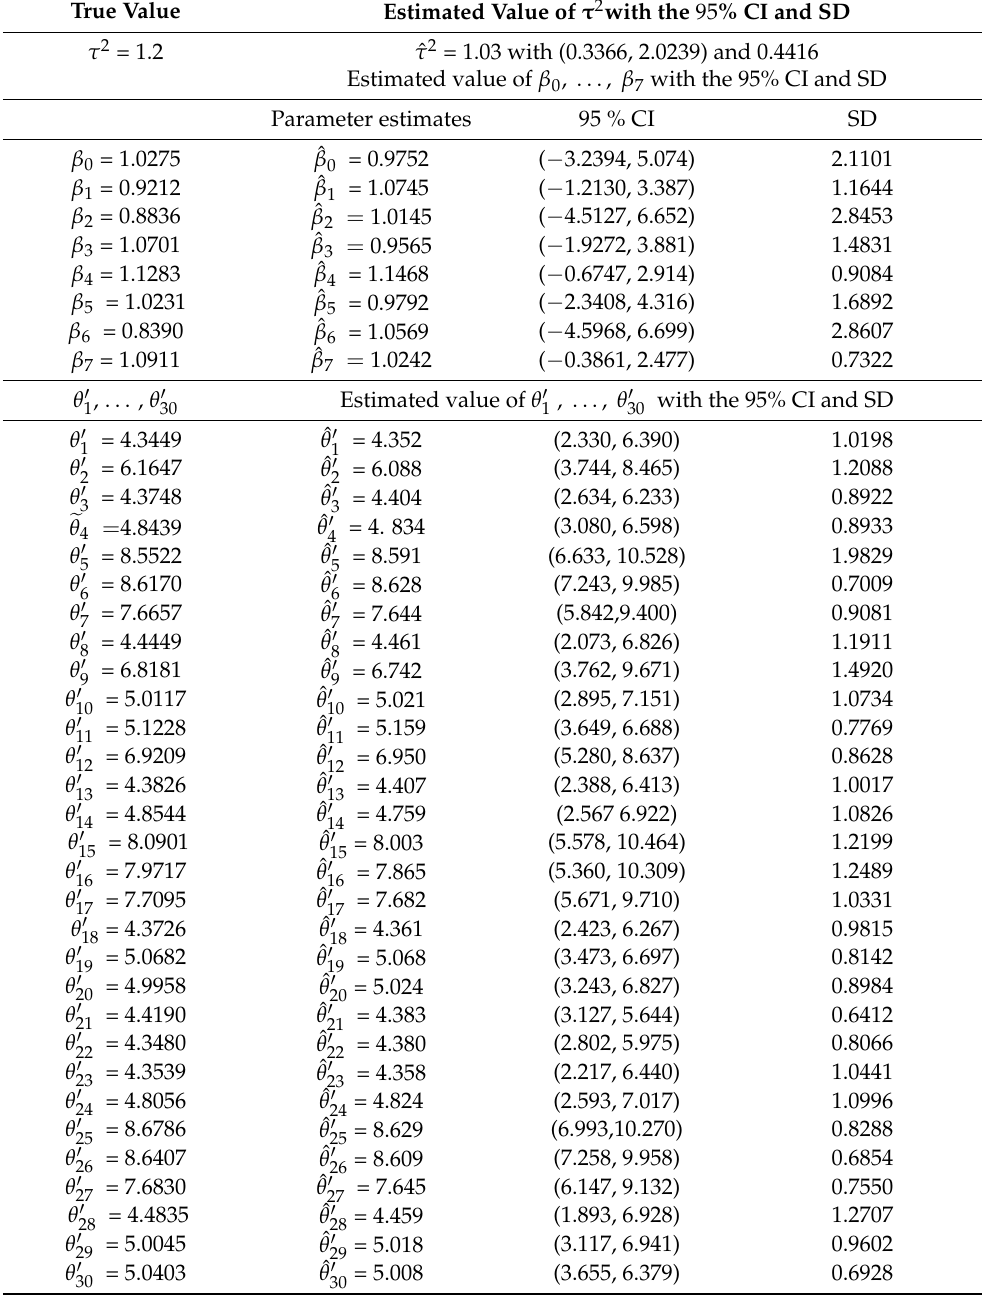
Table 7. Estimated parameters for the HBLD model using the Metropolis within Gibbs algorithm (simulated data).